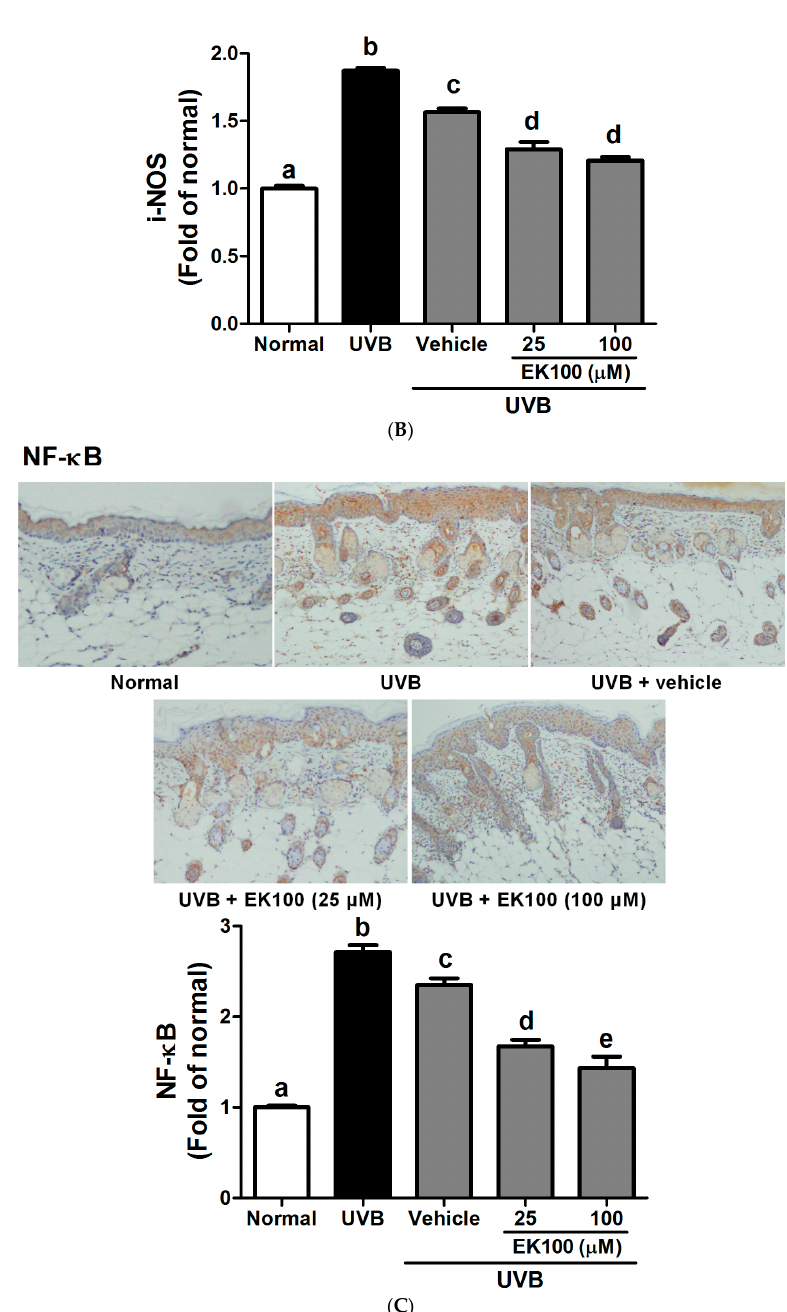
Figure 7. Immunohistochemical staining of IL-6 ( A ); iNOS ( B ); and NF- κ B ( C ) expression in mouse skin slices. UVB irradiation increased the IL-6, iNOS, and NF- κ B expression in mouse skin, while EK100 inhibited the UVB-induced overexpression of IL-6, iNOS, and NF- κ B. a–d : Values not followed by a common letter are significantly different ( p < 0.05).